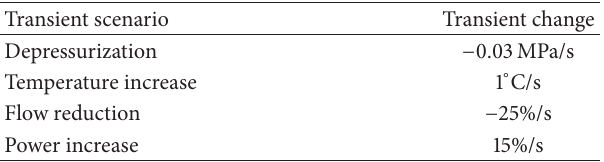
Table 2: Transient parameters of NUPEC PWR test facility. Transient scenario Transient change Depressurization − 0.03MPa/s Temperature increase 1 ∘ C/s Flow reduction − 25%/s Power increase